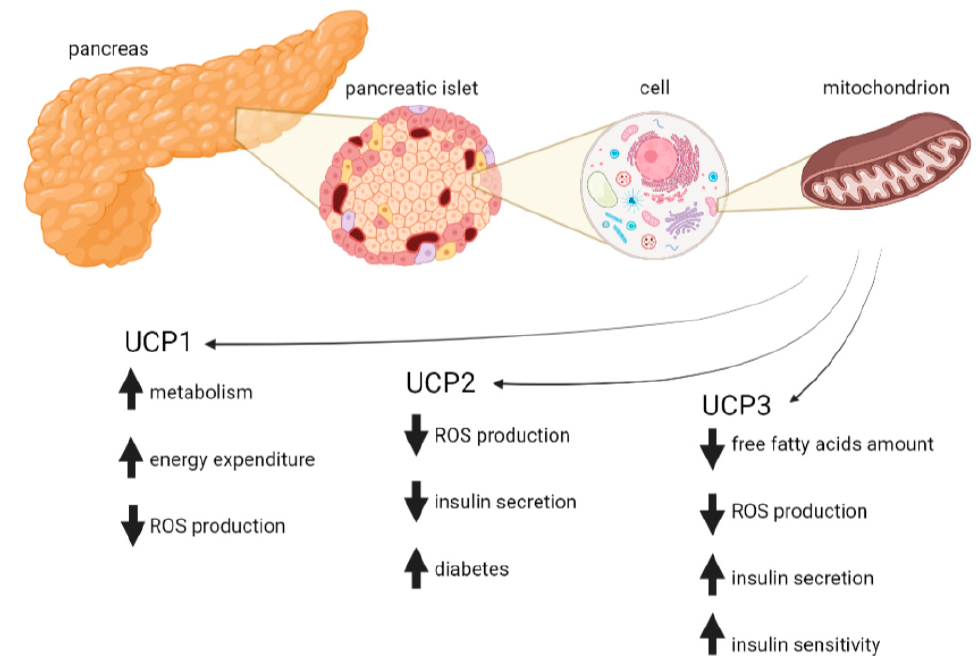
Figure 3. Role of pancreatic UCPs in T2D. The primary role of UCP1 in brown adipose tissue is heat production in a process known as nonshivering thermogenesis. Increased metabolism in pancreatic cells expressing UCP1 increases energy dissipation and reduces mitochondrial ROS production, thereby reducing oxidative stress and the progression of T2D. UCP2 acts as an antioxidant whose expression is stimulated by ROS. Increased UCP2 activity leads to increased proton leakage, which in turn decreases ATP synthesis and the formation of ROS. At the same time, it reduces glucose- stimulated insulin secretion, which may exacerbate T2D. UCP3 affects insulin secretion differently than UCP2. When UCP3 is activated, it reduces ROS production and increases fatty acid oxidation and insulin secretion. Created with BioRender.com.